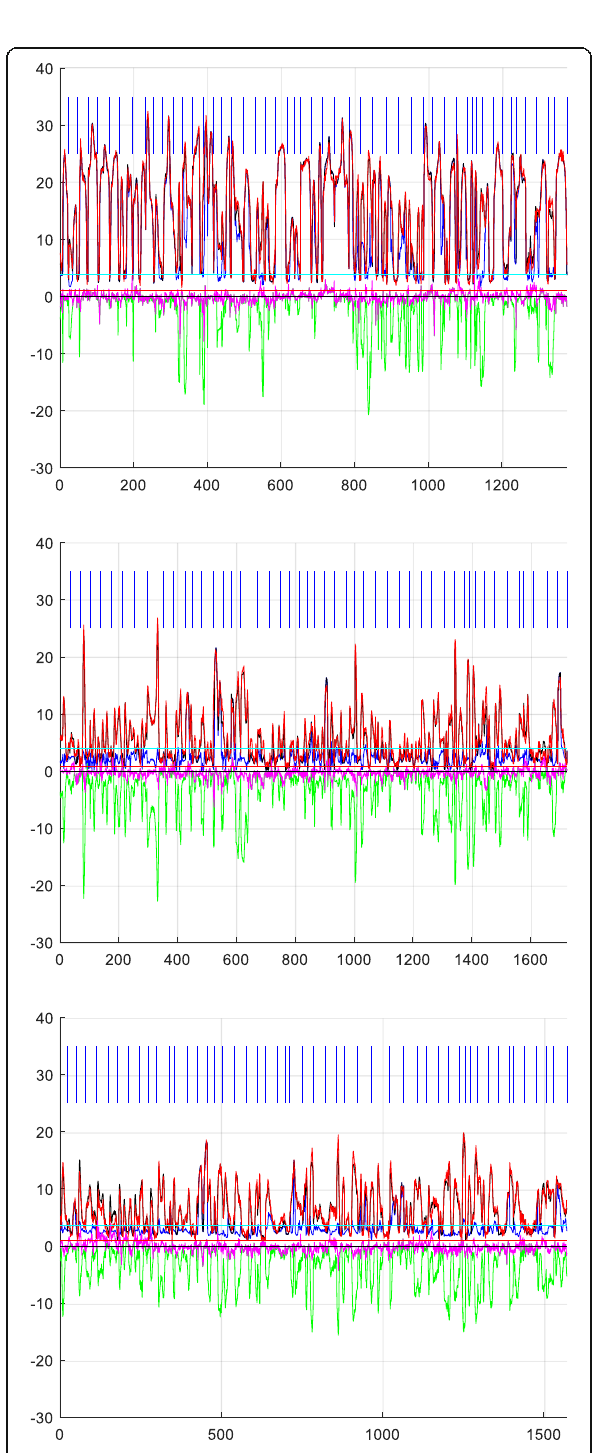
Fig. 15 Red curve : B parameter (expressed in pixels) determined by the ground truth value. Blue curve : B values by original CLNF landmarks. Black curve : B parameter by proposed method. Green curve : errors of original CLNF. Magenta curve : errors of Modified CLNF. The figure shows the result of three speakers from the top to the bottom . The blue short lines at the top are the segmentation for 50 words. The cyan line is the RMSE